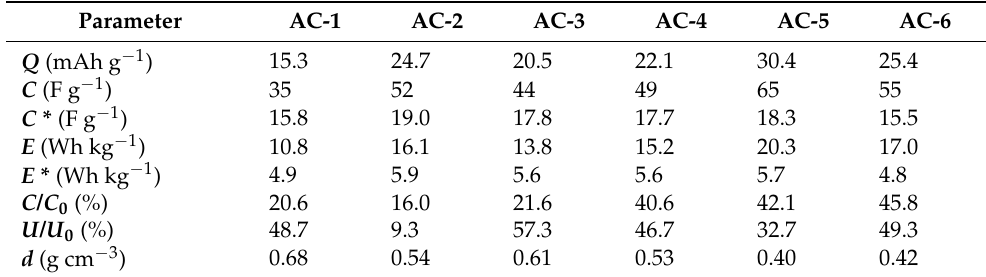
Table 1. Performance metrics of Swagelok ® laboratory